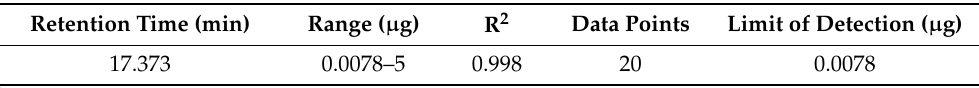
Table 2. Analytical characteristics of the calibration curve 1 for the quantification of EPYR by HPLC.